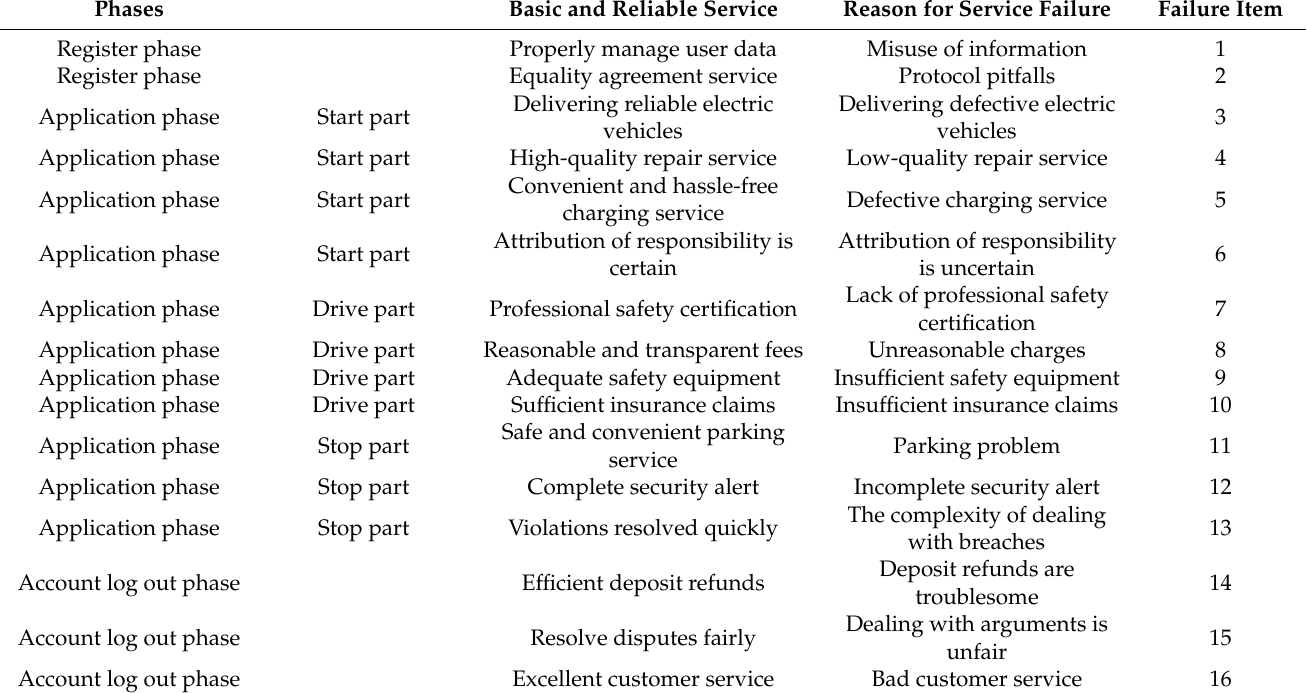
Table 2. The service failure mode and effects analysis (FMEA) of self-service electric